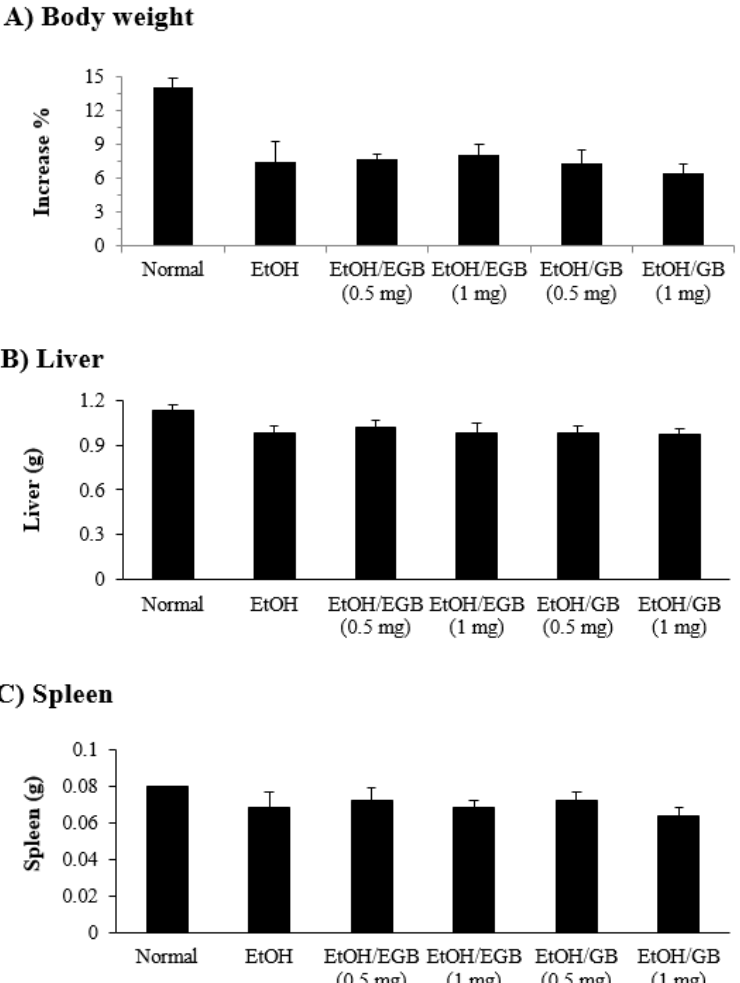
Figure 7. E ff ect of EGB on tissue weight in EtOH-fed mice. Mice were administered p.o. (per oral) with Figure 7. Effect of EGB on tissue weight in EtOH-fed mice. Mice were administered p.o. with EtOH EtOH in the presence or absence of EGB. ( A ) Bodyweight; At the end of EtOH, livers ( B ) and spleens in the presence or absence of EGB. At the end of EtOH, livers and spleens were isolated and ( C ) were isolated and weighed. Bodyweight was expressed as an increase percentage of animal weighed. Bodyweight was expressed as an increase percentage of animal weight.